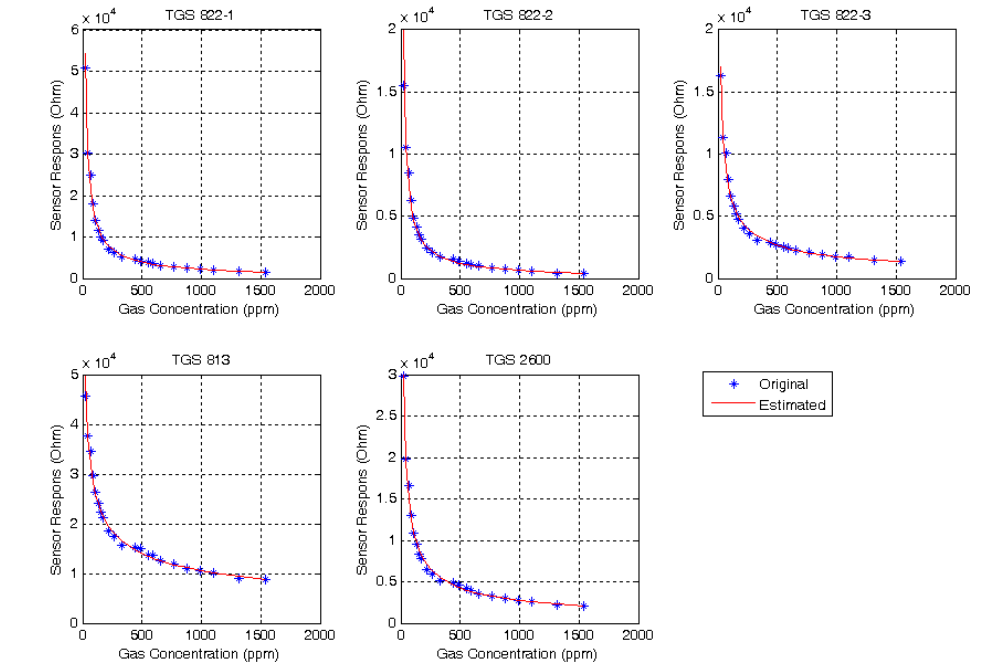
Figure 3. Acetone concentrations vs. sensor resistance for each sensor